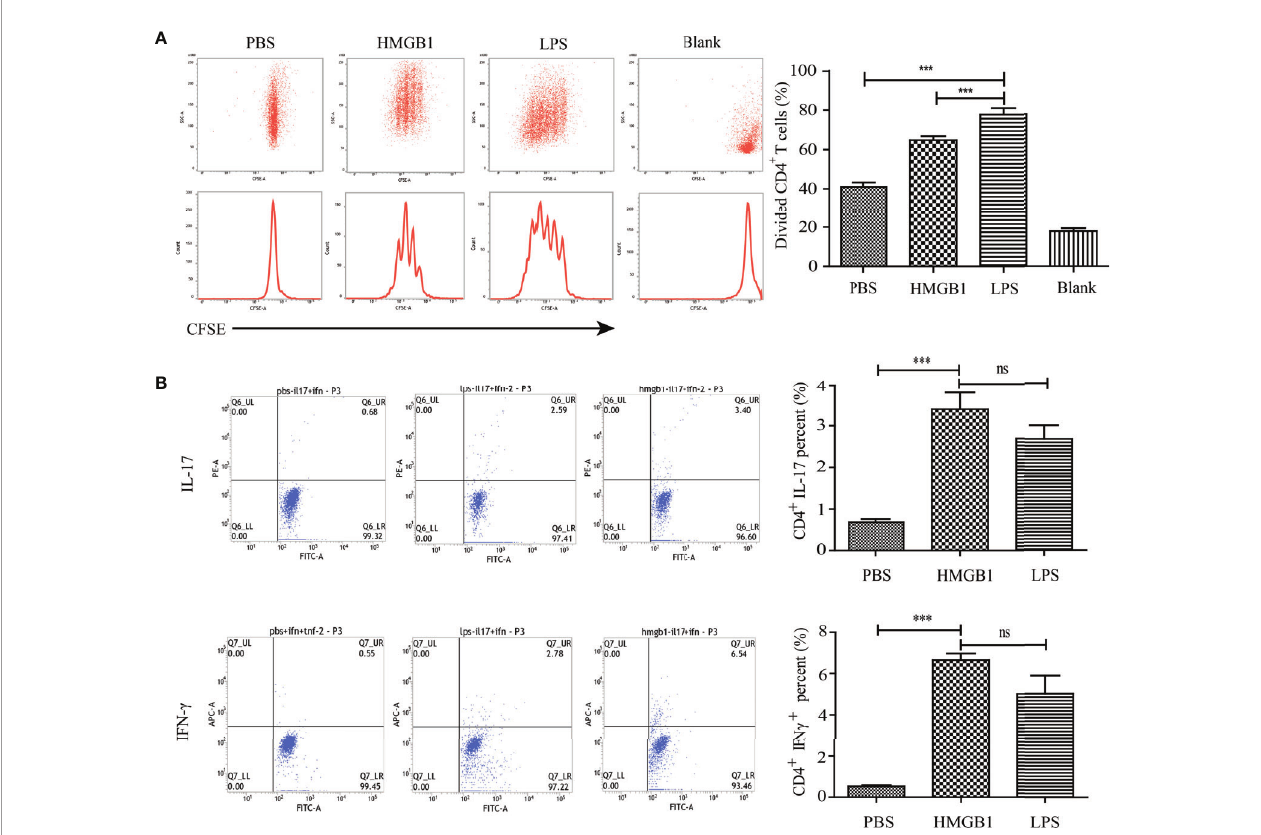
FIGURE 5 | Proliferation and cytokine secretion of CD4+ T cells co-incubated with HMGB1-stimulated DCs. CD4+ T cells were extracted from the spleens of rats and incubated with HMGB1, LPS, or PBS-treated DCs. (A) The proliferation of co-incubated T cells was measured by CFSE labeling. The % proliferation of T cells pulsed by HMGB1-stimulated DCs was higher than those stimulated with control DCs. (B) Representative staining and percentages of IFN- g - and IL-17-producing CD4+ T cells evaluated by fl ow cytometry. Data are expressed as the mean ± SEM from three independent experiments. *** p < 0.001; ns, not signi fi